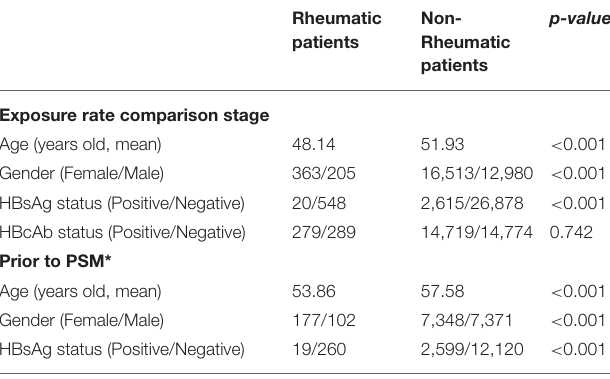
TABLE 1 | Demographic comparison between rheumatic and non-rheumatic patients prior to matching.